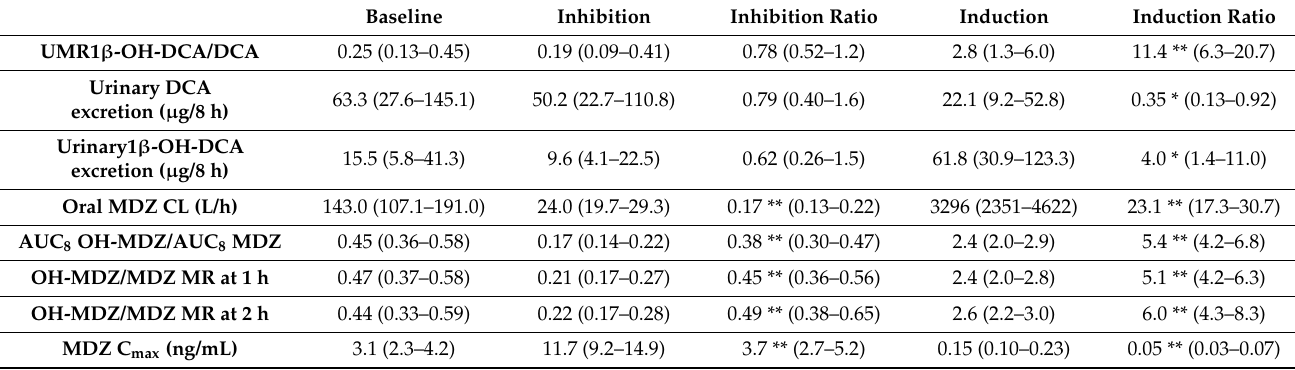
Table 2. Pharmacokinetic parameters of endogenous and exogenous probes before and after the ingestion of inhibitors and the inducer, including inhibition and induction ratios.